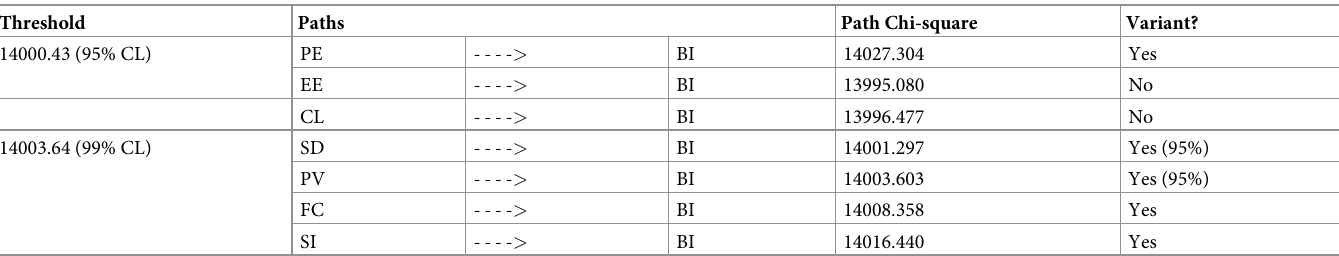
Table 10. Path by path analysis. Threshold